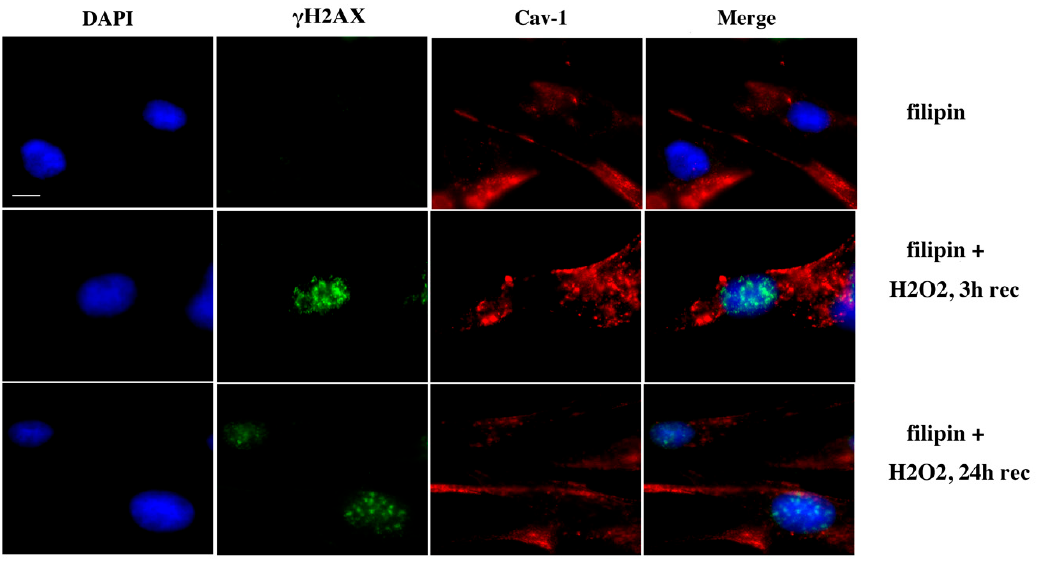
Figure 10. Filipin prevents caveolin-1 nuclear translocation. Characteristic images of caveolin-1 localization evaluated by anti-cav-1 antibody (red) in control chondrocytes treated with filipin for 24 h (filipin) before exposing cells to H 2 O 2 and allowing them to recover for 3 h (filipin + H 2 O 2 , 3 h rec) and 24 h (filipin + H 2 O 2 , 24 h rec). DNA damage ( γ H2AX, green) was also assessed and nuclei were stained with DAPI (blue). Images were captured with the 100× oil immersion objectives of the fluorescent microscope used. Scale bar 25 μ m.